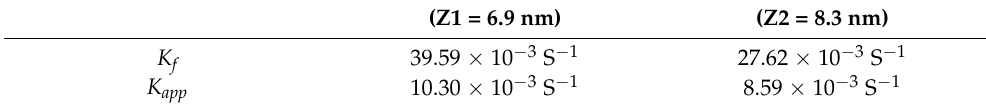
Table 1. Fluorescence rate constant ( K f ) and photodegradation rate ( K app ) for ZQDs prepared